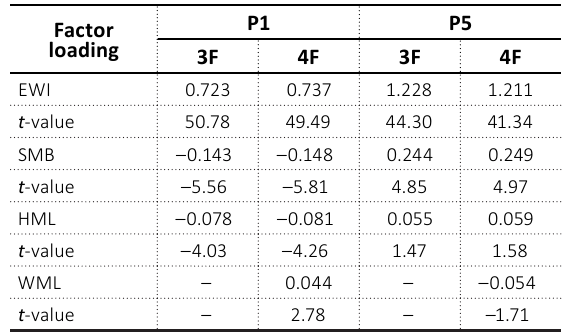
Table 3. Three-factor and four-factor regression coefficients of volatility extreme portfolios